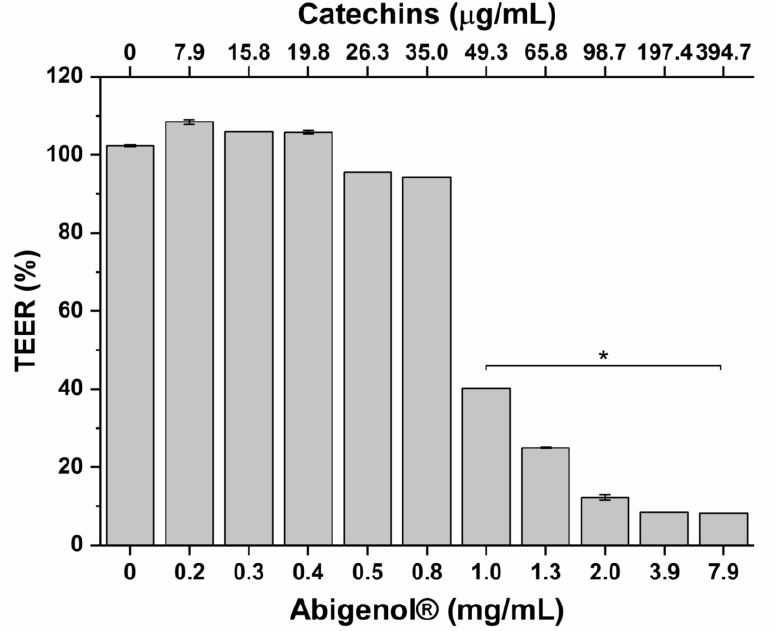
Figure 3. Impact of increasing concentrations of digested Abigenol ® /AlbiPhenol ® on the barrier integrity of the intestinal epithelium. * p < 0.05. (n = 3).